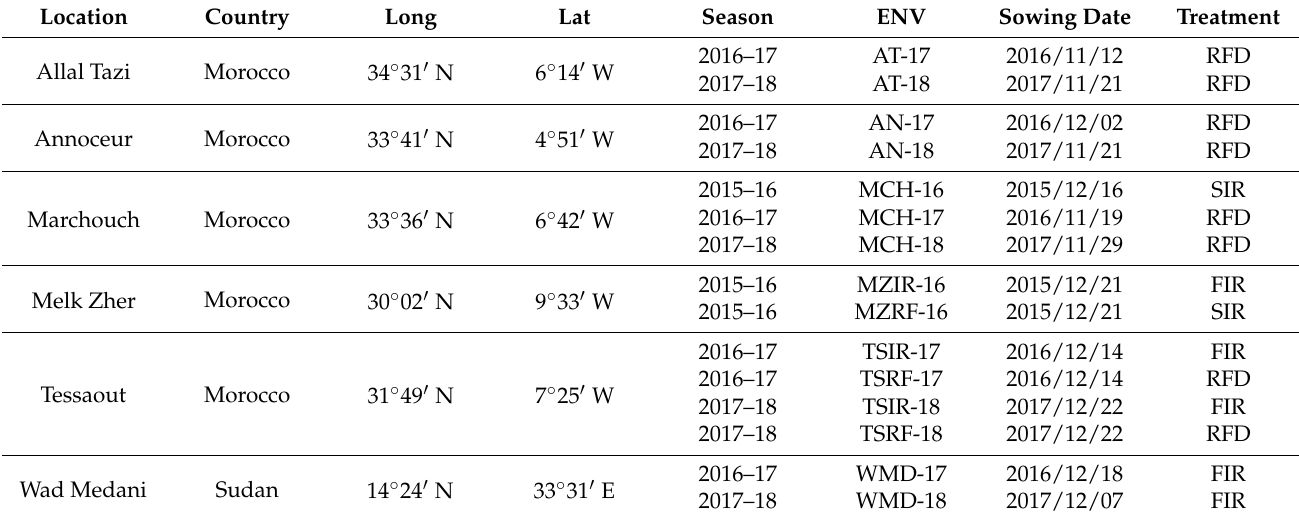
Table 2. Location, seasons, and codes for the testing environments of durum wheat